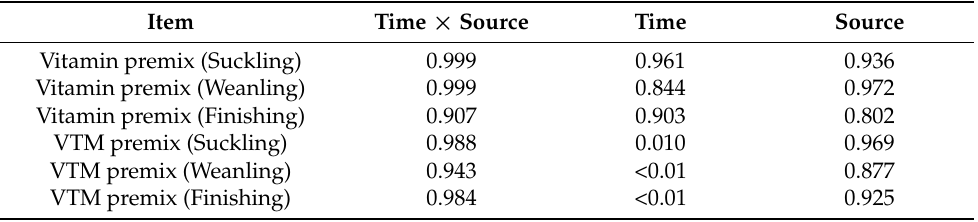
Table 2. The interaction effect and main effect probability of storage time and vitamin A source on the stability of vitamin A in vitamin and vitamin-trace mineral (VTM)